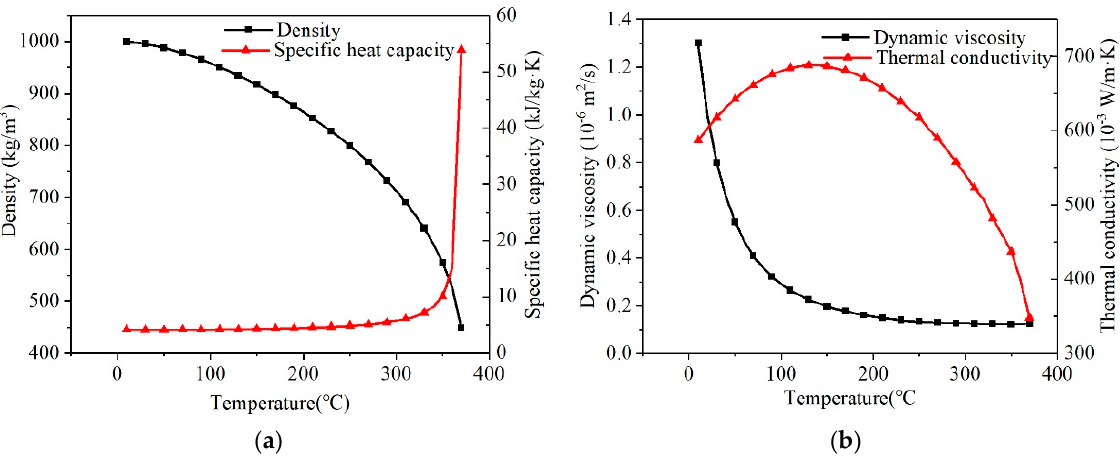
Figure 8. Material parameters of water at different temperatures. ( a ) Density. ( b ) Dynamic viscosity.